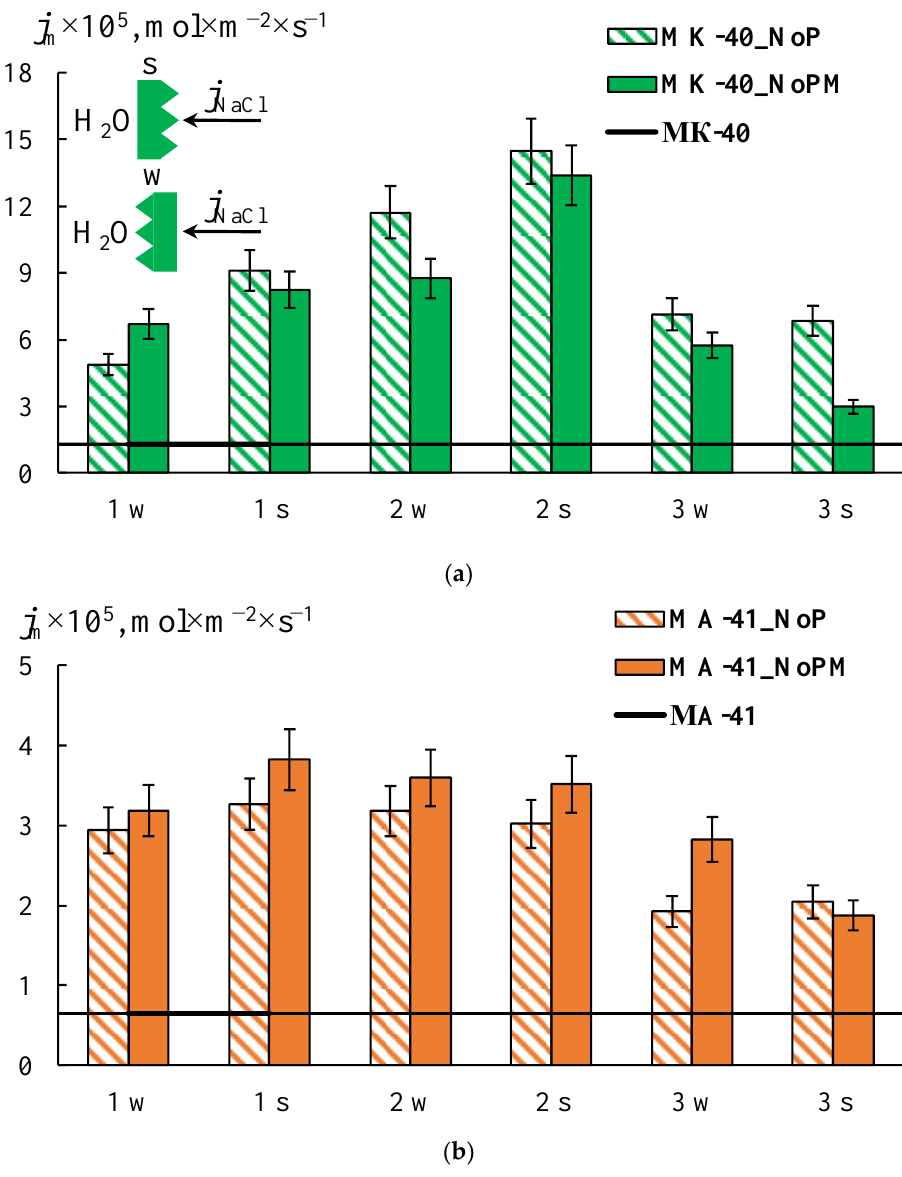
Figure 8. The flux density for the initial MK-40 ( a ) and MA-41 ( b ) membranes (line), the profiled membrane (shaded rectangles), and the profiled membranes with an MF-4SK layer (one-colored rectangles) in a 1 M NaCl solution. The number on the abscissa axis corresponds to the number of the sample profile in Table 1, and the letter corresponds to the orientation of the sample.